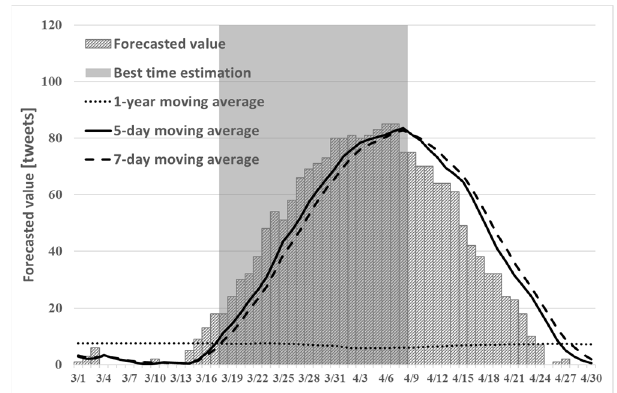
Figure 9. Kyoto after forecasting in 2019 (proposed method (2)).